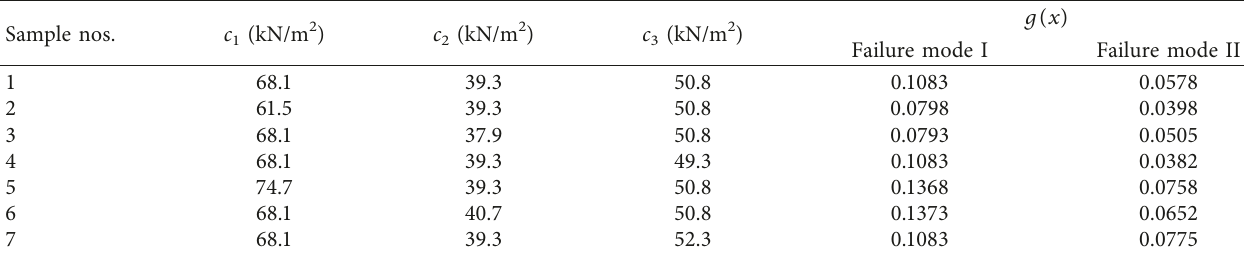
Table 13: The initial learning samples of Example 4.